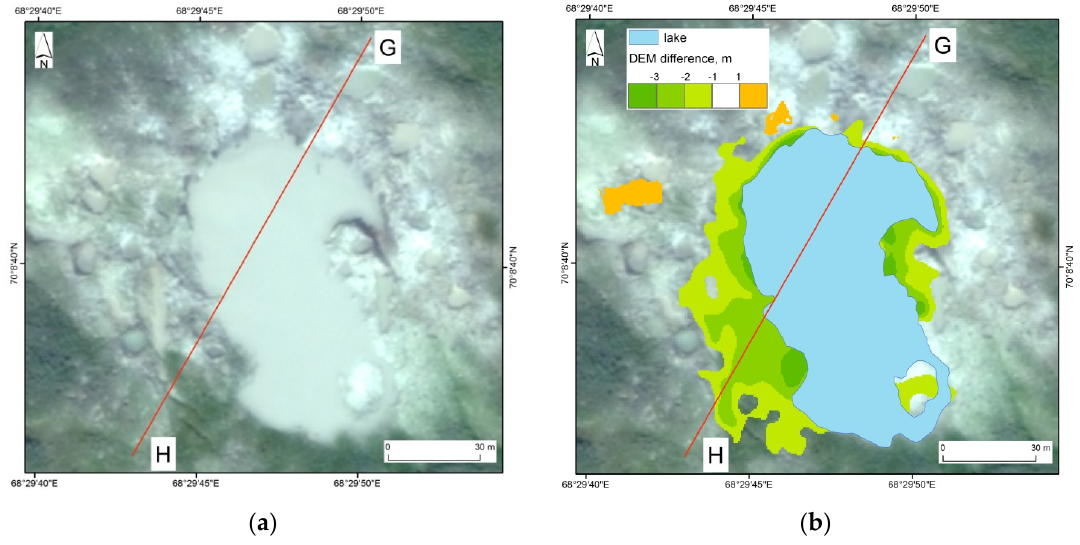
Figure 6. The difference between DSMs obtained “before” (2010–2011) and “after” (2013) GEC-2 formation): ( a ) WorldView-2 image dated 21 July 2013; ( b ) A fragment of DSM difference. Differences in elevation predominantly occur in a well-defined area, located southwest of the lake. See the GH profile in Figure 5.